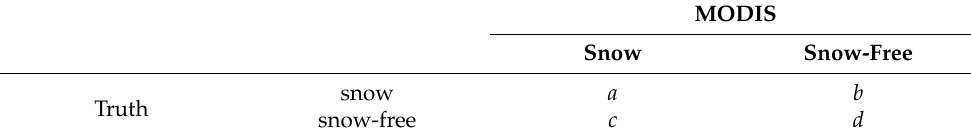
Table 2. Confusion matrix. MODIS Snow Snow-Free snow a b Truth snow-free c